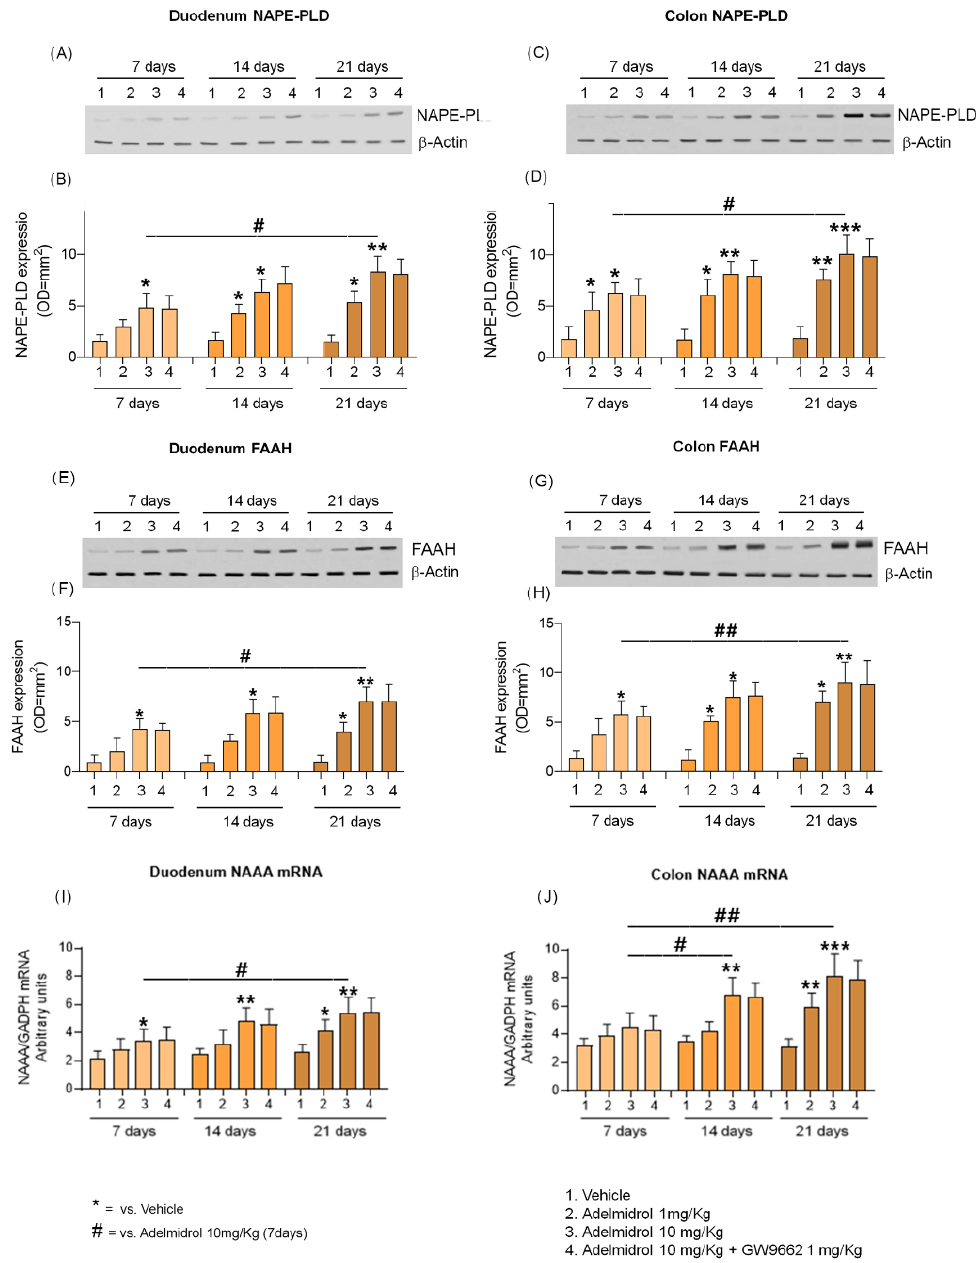
Figure 3. Effect of daily administration of Adelmidrol (1–10 mg/Kg) on NAPE-PLD and FAAH protein expression and NAAA-coding mRNA in the duodenum and colon of treated mice, respectively, in the presence and absence of specific PPAR- γ inhibitor GW9662 (1 mg/Kg). ( A , C , E , G ) Immunoreactive bands referred to NAPE-PLD and FAAH proteins expression measured at 7, 14, and 21 days in duodenum and colon, and ( B , D , F , H ) relative densitometric analysis of each protein (arbitrary units normalized on the expression of the housekeeping protein β -Actin). ( I ) The NAAA gene expression in duodenum measured at 7, 14, and 21 days. ( J ) The NAAA gene expression in colon measured at 7, 14, and 21 days. Results are expressed as mean ± SD of n = 4 experiments performed in triplicate. * p < 0.05, ** p < 0.01, and *** p < 0.001, respectively, versus vehicle of the same timepoint. # p < 0.05 and ## p < 0.01 versus Adelmidrol (10 mg/Kg) at day